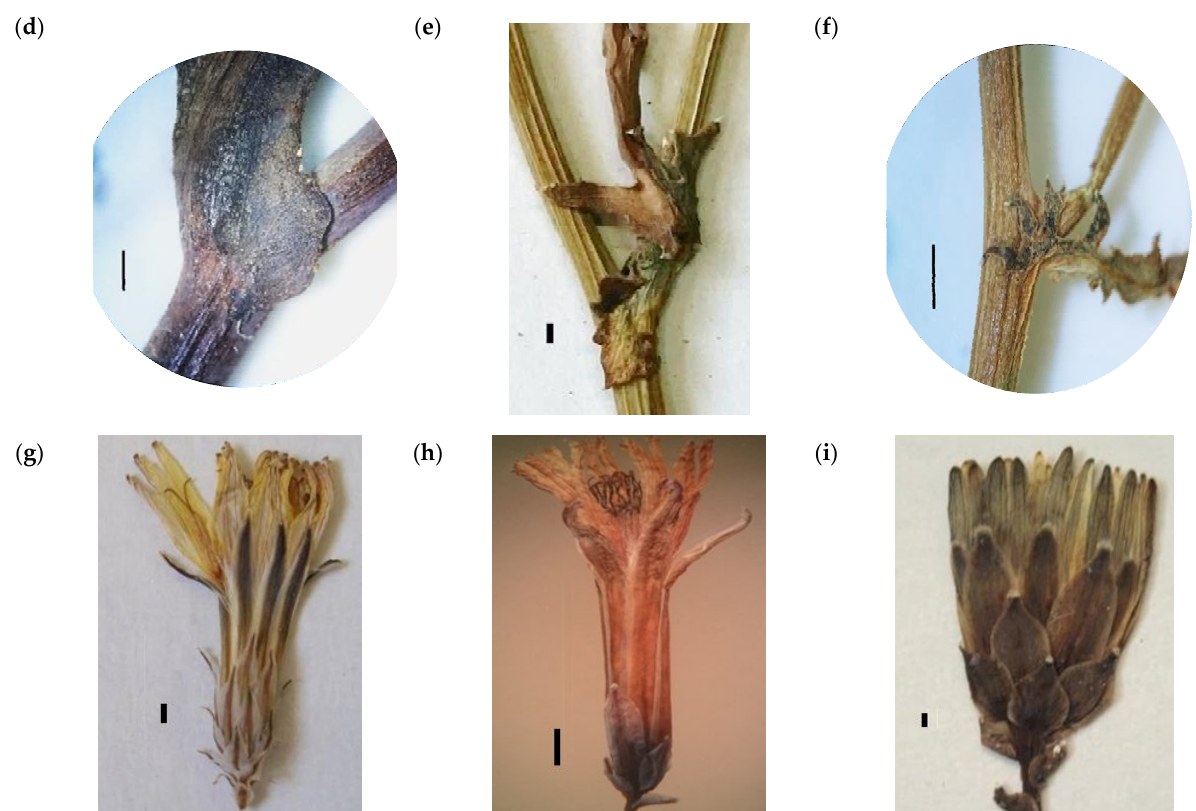
Figure 1. Stereomicrographs of Launaea leaves and capitula. ( a – f ) Leaf attachment and auricle margin; ( a ) Non-auriculated leaf in L. nudicaulis ; ( b , c ) auriculated with semi-amplexicaul base in L. fragilis subsp. fragilis ; ( b ) entire margin or ( c ) dentate margin; ( d – f ) auriculated with amplexicaul base; ( d ) entire margin in L. fragilis subsp. fragilis or ( e ) dentate margin in L. fragilis subsp. fragilis or ( f ) dissected margin in L. mucronata subsp. cassiniana . ( g – i ) Capitulum shape, involucre scale graduality and ligule color; ( g ) ellipsoid, non-gradual and yellow ligule; ( h ) lanceoloid, non-gradual and yellow ligule; ( i ) obovoid, gradual and yellow ligule with green abaxial surface. Scale bar = 1 mm.